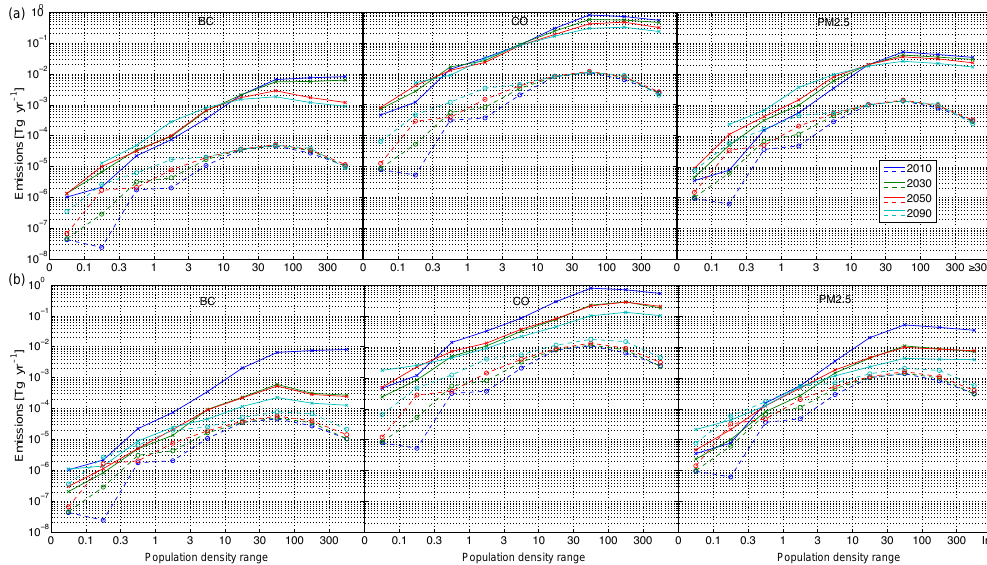
Figure 4. Monthly anthropogenic (solid lines, crosses) and wildfire emissions (dashed lines, circles) of selected pollutants for Europe during peak fire season by range of population density for different time windows and the SSP5 population scenario. (a) RC4.5 with current legislation anthropogenic emissions. (b) RCP8.5 with maximum feasible reductions anthropogenic